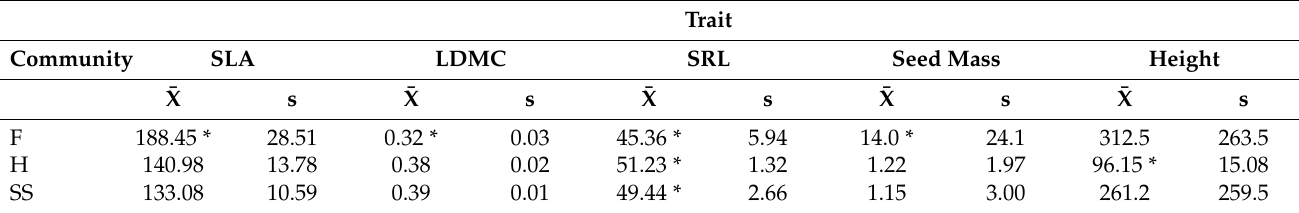
Table 2. Mean and standard deviation of trait values for the specific leaf area (SLA), leaf dry matter content (LDMC), specific root length (SRL), seed mass, and height of plants in three alternate states: forest (F), heath (H), and shrub savannah (SS). * Indicates significant difference at p <